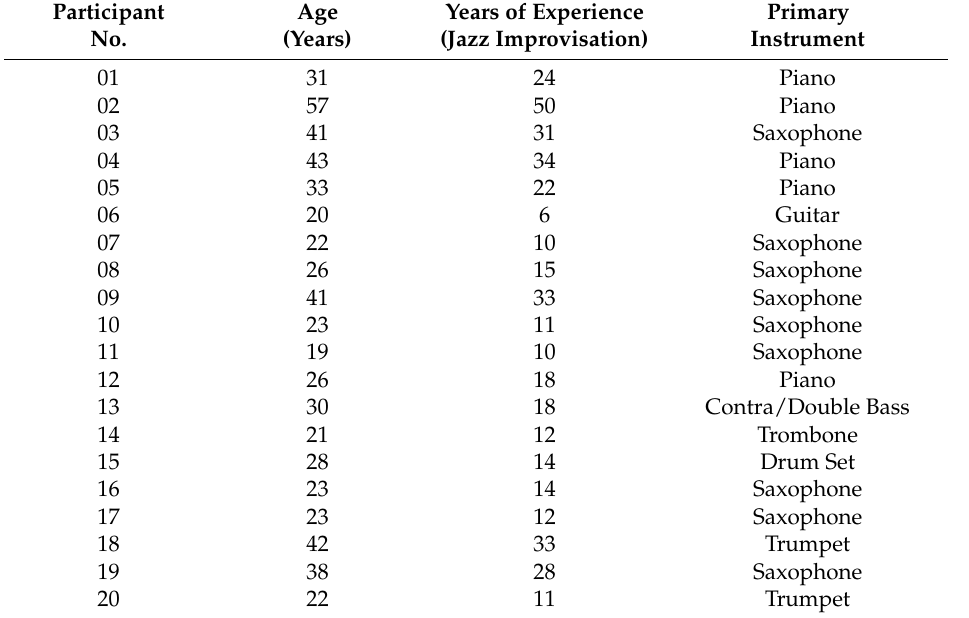
Table 1. Age, the primary musical instrument, and years of experience (jazz experience) of the advanced jazz improvisers in this